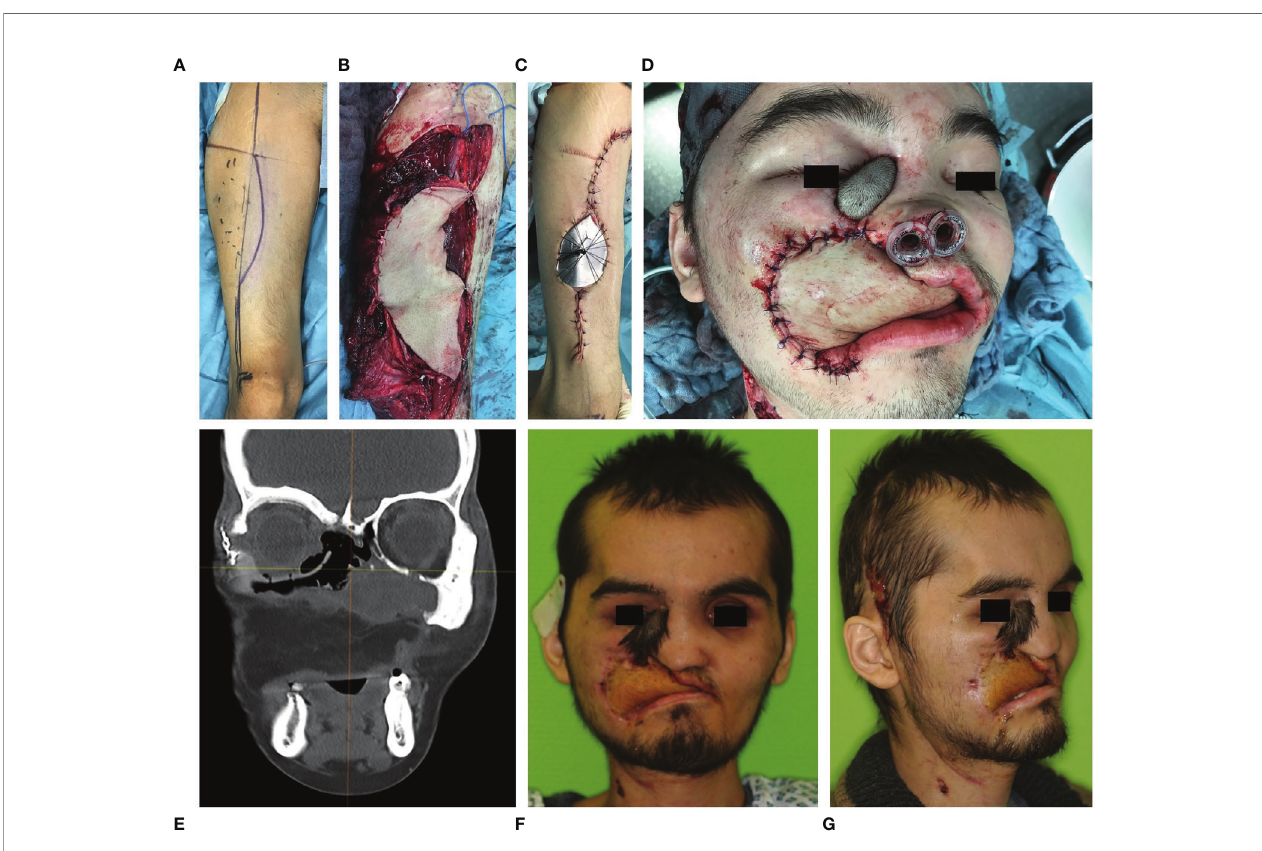
FIGURE 8 | Early secondary soft tissue reconstruction of the upper lip and jaw using an anterolateral thigh fl ap in a case of Ewing ’ s sarcoma of the midface. (A – C) Skin marking, fl ap harvest and wound closure of the anterolateral thigh fl ap of the right lower extremity. (D) Anterolateral thigh fl ap sewed in. (E) Postoperative CT scan in coronal plane shows the patient speci fi c implant in situ reconstructing the right orbital fl oor while the symmetrical position of the eyeball has been restored. (F) Frontal and (G) half site view of the patient two months after tumor resection and two stage reconstruction (primary orbital fl oor and early secondary soft tissue of the upper lip and